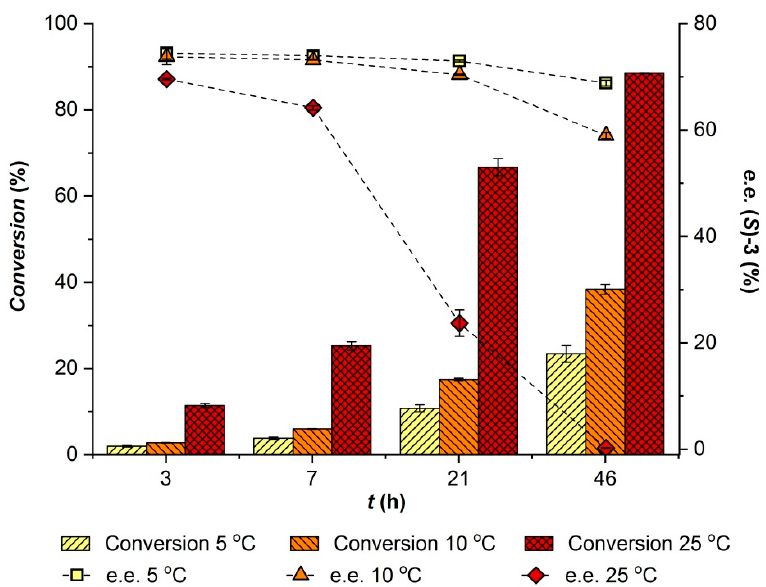
Figure2. E ff ectoftemperatureonCALA-catalyzedbenzoylationof65mM( ± )-4-methoxymandelonitrile Figure 2. Effect of temperature on CALA-catalyzed benzoylation of 65 mM using 200 mM phenyl (±)-4-methoxymandelonitrile using 200 mM phenyl benzoate.